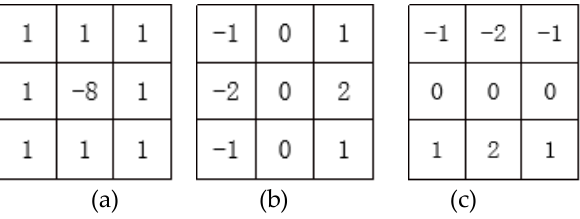
Figure 20. Convolutional kernels of the second convolutional layer: (a) gradient Laplacian convolutional kernel, (b) horizontal Sobel convolutional kernel, and (c) vertical Sobel convolutional kernel.